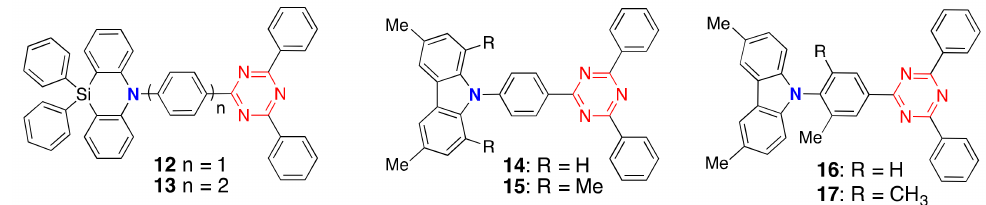
Figure 3. Triazine-based TADF